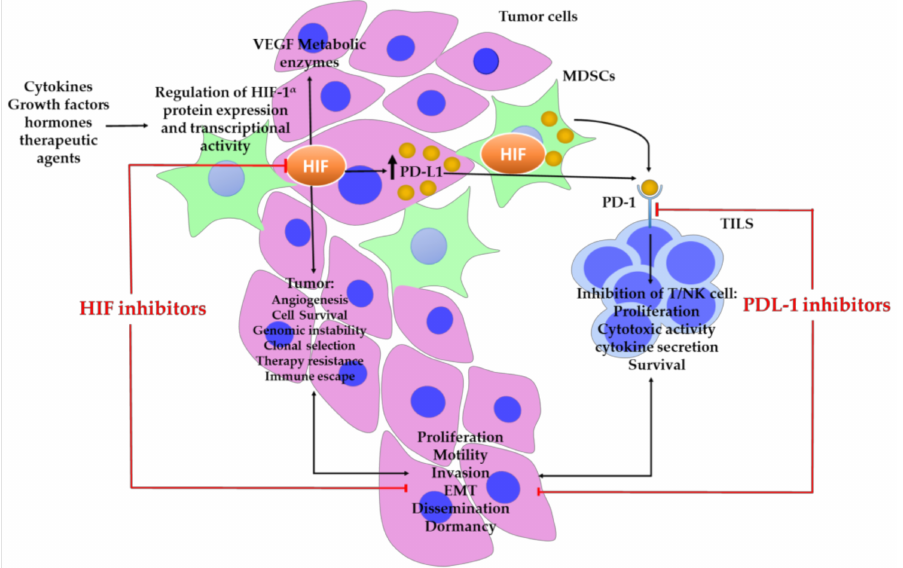
Figure 7. The majority of solid tumors acquire hypoxia as a result of disorganized vascularization, which deprives the tumor of optimum oxygen supply and results in increased cellular proliferation and metabolic rate. Hypoxia activates and stabilizes essential transcription factors, the hypoxia- inducible transcription factors (HIFs). HIF-1 α and HIF-2 α regulate the expression of several genes involved in cancer. HIFs enhance tumor growth by increasing angiogenesis, immunosuppression, EMT, and metabolic reprogramming, as well as by promoting malignant cell survival, motility, proliferation, and plasticity, and by enhancing treatment resistance and escape from a nutrient- deprived environment. Hypoxia also upregulates PD-L1 expression in cancer cells and MDSCs via HIF-1 α and HIF-2 α . By attaching to its receptor (PD-1), PD-L1 functions as a pro-tumorigenic factor that develops immunological tolerance within the tumor microenvironment, and suppresses antitumor immune responses by inhibiting the activity of tumor-specific TILs. Together, HIF-1 α and PDL-1 inhibition decrease tumor formation and progression. More research is required to identify how additional variables in the tumor microenvironment, including cytokines, chemokines, growth factors, hormones, and therapeutic drugs, may impede the antitumor efficacy of HIF-1 α inhibitors and anti-PDL-1 therapy in